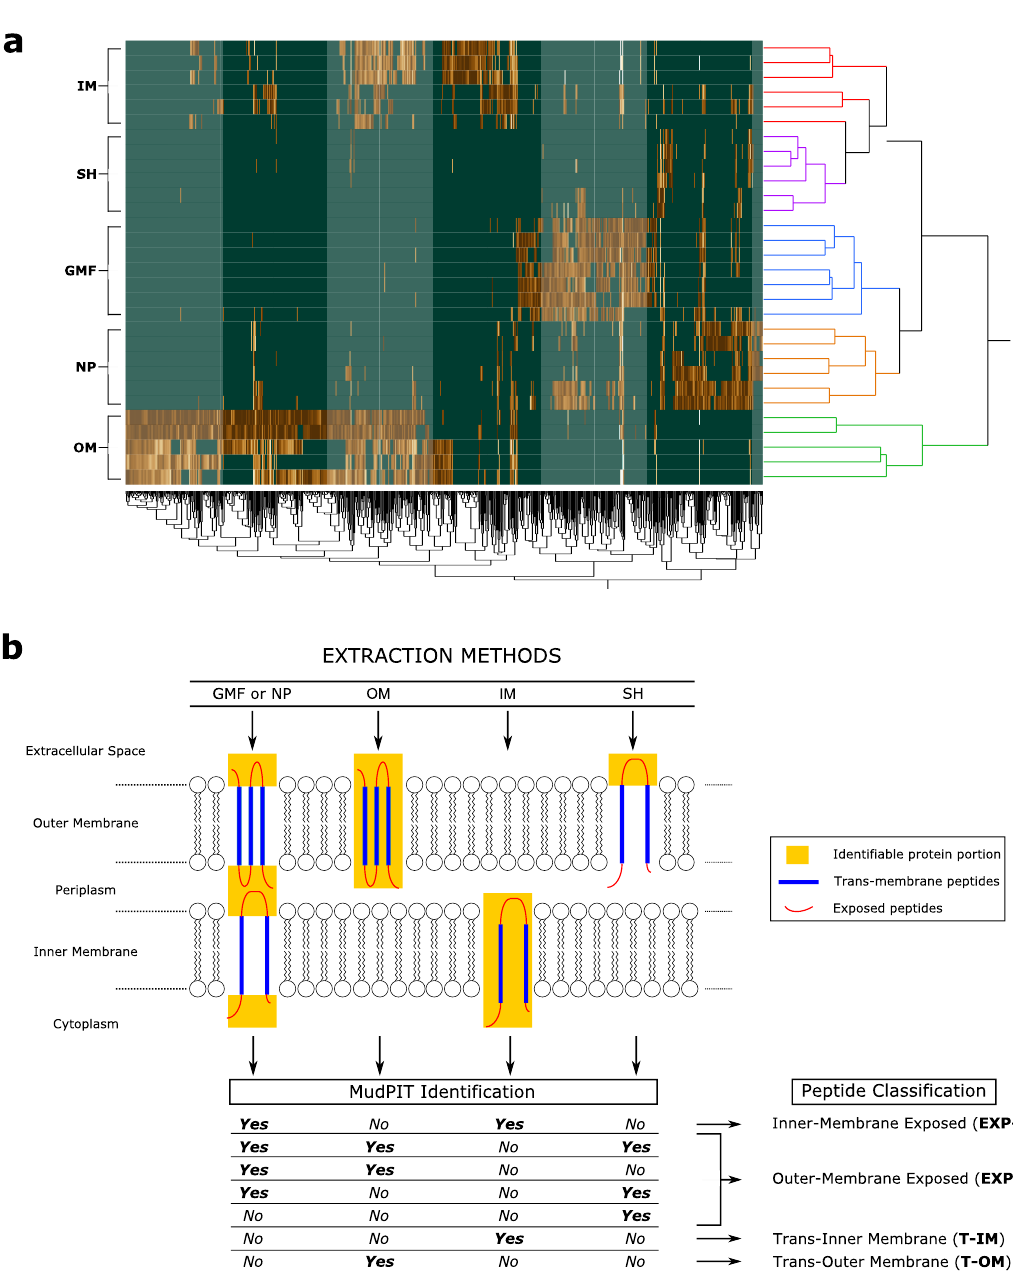
Figure 4. ( a ) Hierarchical clustering performed by computing the Xcorr values (cross-correlation between the experimental mass spectra and those theoretically predicted) of peptides ( n = 722) specifically enriched following the extraction methods applied (LDA, p ≤ 0.01). Euclidean distance metric and Complete’s method were used. ( b ) Membrane protein portions (in yellow) enriched by IM (Inner Membrane), OM (Outer Membrane), GFP (Global Membrane Fraction), SH (Shaving) and NP (Nanoparticles). Combinations of MudPIT results used to classify peptides in Inner-Membrane Exposed (EXP-IM), Outer-Membrane Exposed (EXP-OM), Trans-Inner Membrane (T-IM) and Trans-Outer Membrane